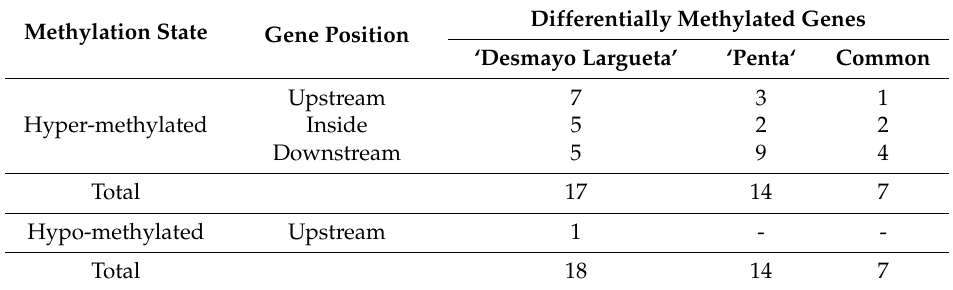
Table 3. The number of differentially methylated genes between the A and B dormancy states of flower buds, identified from sequenced fragments mapped to the P. persica genome (v2.1). Differentially Methylated Genes Methylation State Gene Position ‘Desmayo Largueta’ ‘Penta‘ Common Upstream 7 3 1 Hyper-methylated Inside 5 2 2 Downstream 5 9 4 Total 17 14 7 Hypo-methylated Upstream 1 - - Total 18 14